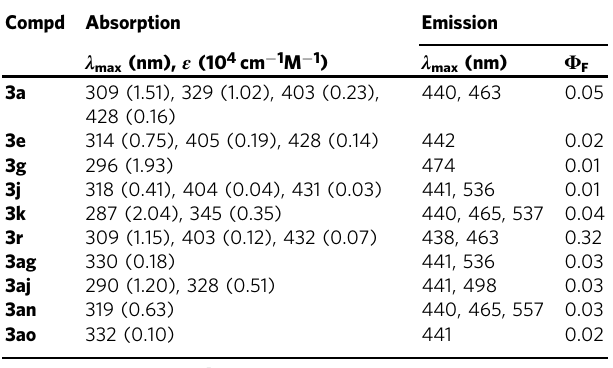
Fig. 9 Optical properties of 3. a Absorption spectra of benzo[6,7]azepino[2,3- b ]quinolines in DCM (10 μ M). b , c Emission spectra of benzo[6,7] azepino[2,3- b ]quinolines in DCM at room temperature (10 μ M). d Emission spectra of 3r in solvents of different polarities. Fig. 75. General procedure for the synthesis of benzo[6,7]azepino[2,3- b ]quinolines Table 2 Photophysical data of benzo [6,7]azepino[2,3-b] 3 is supplied: see Supplementary Fig. 76. General procedure for the synthesis of quinolines a pyridine-based diones 5 are supplied: see Supplementary Fig. 77. Synthetic appli- cations are supplied: see Supplementary Figs. 78 – 80. Crystal data are supplied: see